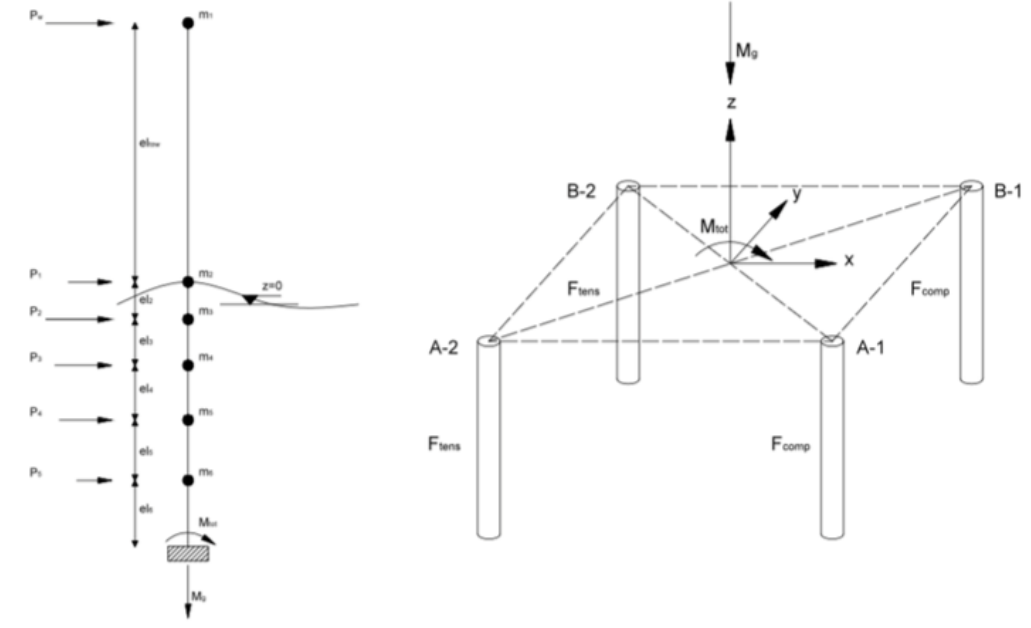
Figure 10. Pile stress analysis of the 6DOF